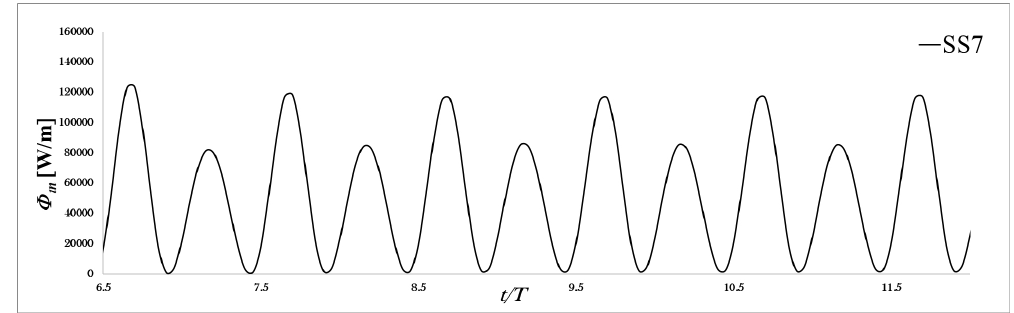
Figure 9. Instantaneous energy flux in the AA (cid:48) section, placed at 2.5 L from the wavemaker of Figure 8 ( H = 2.5 m, T = 8